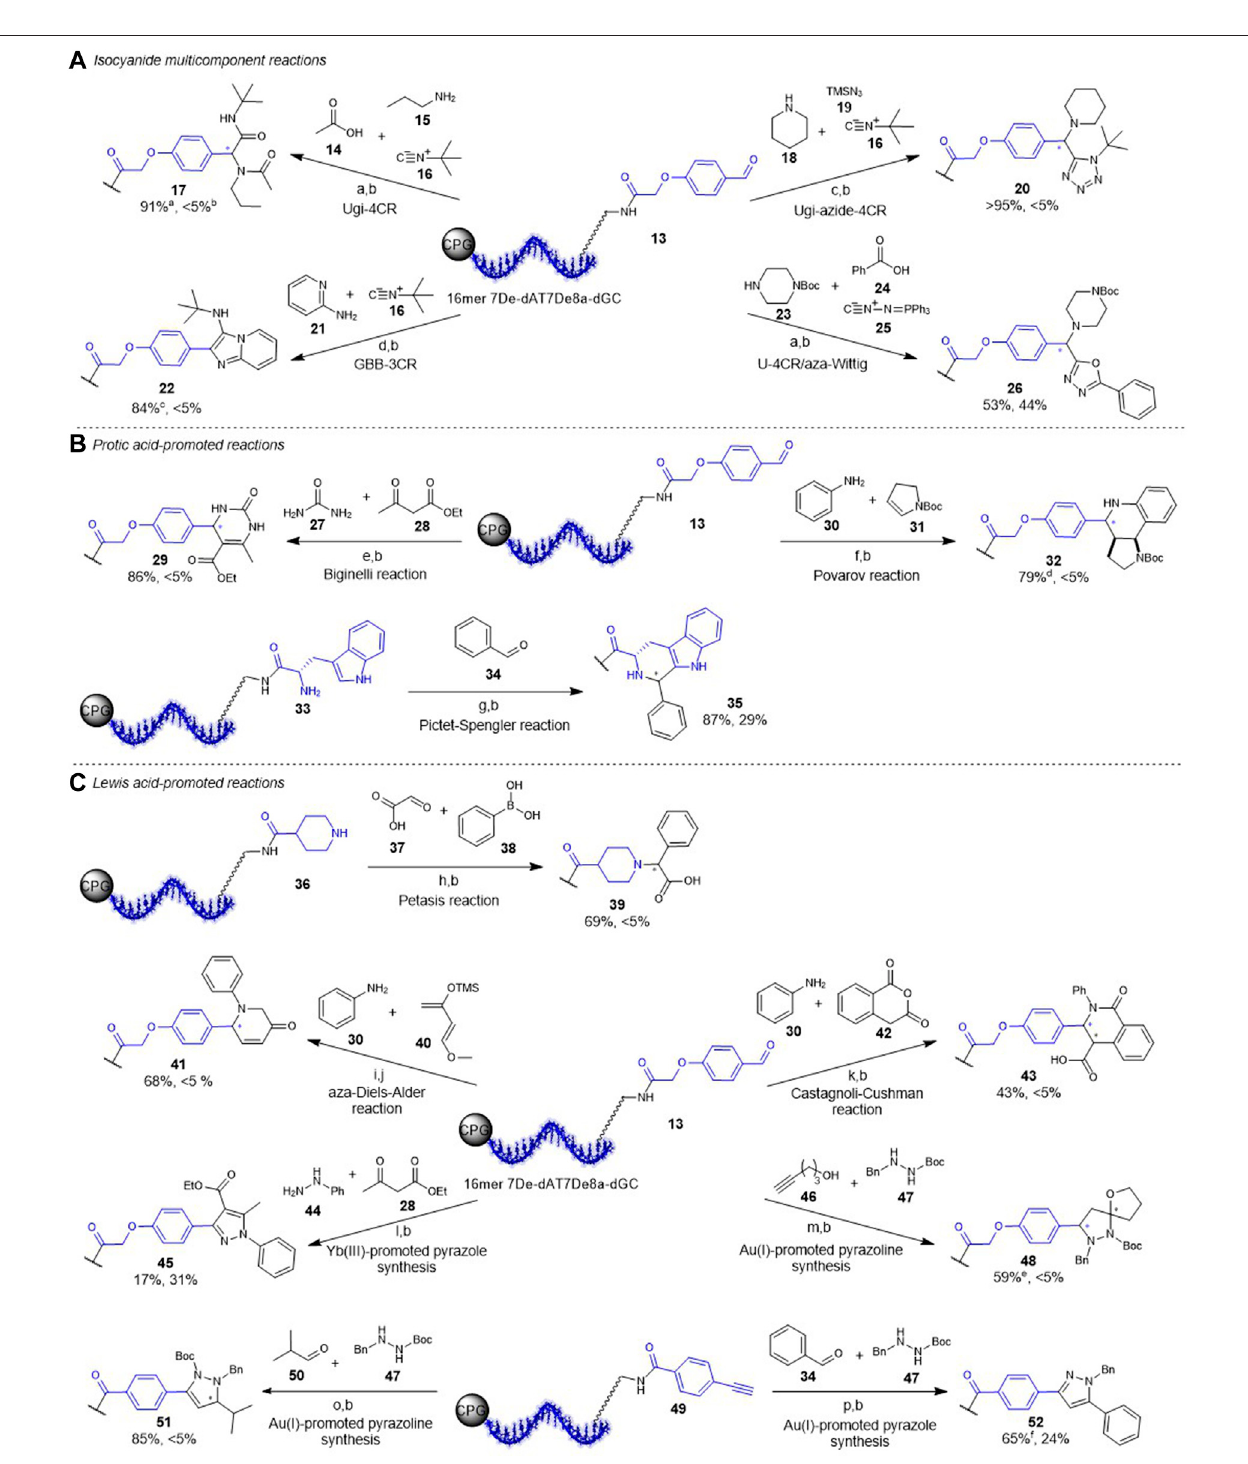
FIGURE3| TranslationofreactionstoCPG-boundDNA-startingmaterials. (A) IsocyanideMCRchemistries;a)MeOH,50 ° C,b)aq.NH3/MeNH2(AMA),c)MeOH, 50 ° C, d) 1% acetic acid/MeOH, 50 ° C. (B) Protic acid-promoted reactions; e) (R) -(-)-BNDHP, EtOH 50 ° C, f) (R) -(-)- BNDHP, EtOH/TEOF, 50 ° C, g) 5% TFA, CH 2 Cl 2 , rt. (C) Metal ion-promoted reactions; h) CuCl/bpy, DMF/TEOF, 50 ° C, i) ZnCl 2 , ACN/TEOF, rt, j) aq. NH 3 , 50 ° C, 6 h, k) Yb(OTf) 3 , CH 2 Cl 2 /TEOF, rt, l) Yb(PFO) 3 , toluene, 50 ° C,m)AuI/AgSbF 6 ,THF,rt,n)IprAuCl/AgOTf,ACN,50 ° C,o)AuI/AgOTf,glacialaceticacid,60 ° C.p)10%TFAinH 2 O,4h. a,b ConversionandDNAdegradation determined by HPLC. c additional 11% of unde fi ned byproduct. d additional 12% of unde fi ned byproduct. e additional 15% of unde fi ned byproducts. f additional 20% of unde fi ned byproducts. AuI=[Tris(2,4-di-tert-butylphenyl)phosphite]-gold chloride. Sequence of all DNA oligonucleotides used in the reactions: CT*C TCT 7De8a-dGTC T7De8a-dGT 7De-dACC T.